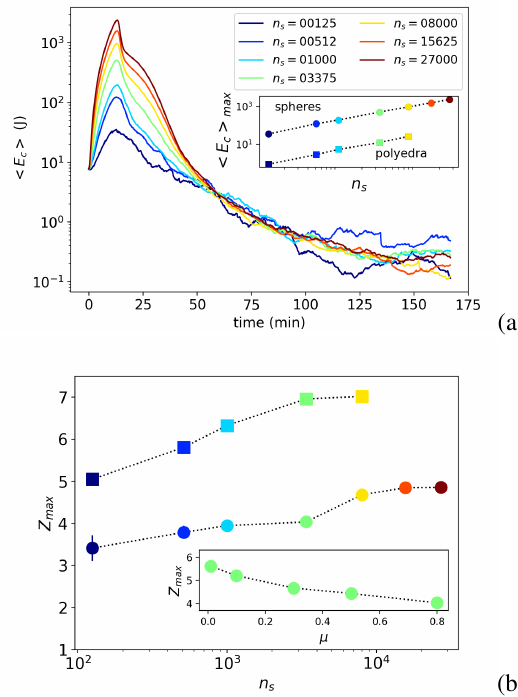
Figure 4. (a) Log-log representation of D max / d , as a function of n s in assembly of spheres (disks symbols) and polyhedra (square symbols) at µ = 0. (b) ⌫ as a function of n s in assembly of spheres ( ) and polyhedra ( ⌅ ) at µ = 0. Inset: variation of both, ⌫ and d max as a function of µ in aggregates of spheres for n s = 3375. Di ↵ erent colors correspond to di ↵ erent particle